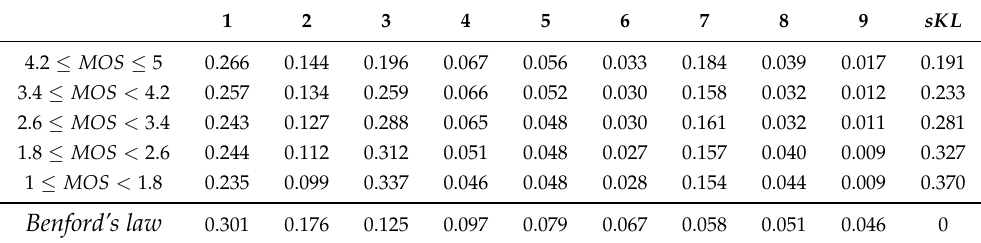
Table 4. Mean FDD of HHL wavelet coefficients in KoNViD-1k [22] with respect to different MOS intervals. In KoNViD-1k [22], the lowest possible video quality is represented by MOS = 1.0, while MOS = 5.0 stands for the highest possible video quality. In the last column, the symmetric Kullback– Leibler ( sKL ) divergences between the actual FDD and the Benford law distribution are given. 1